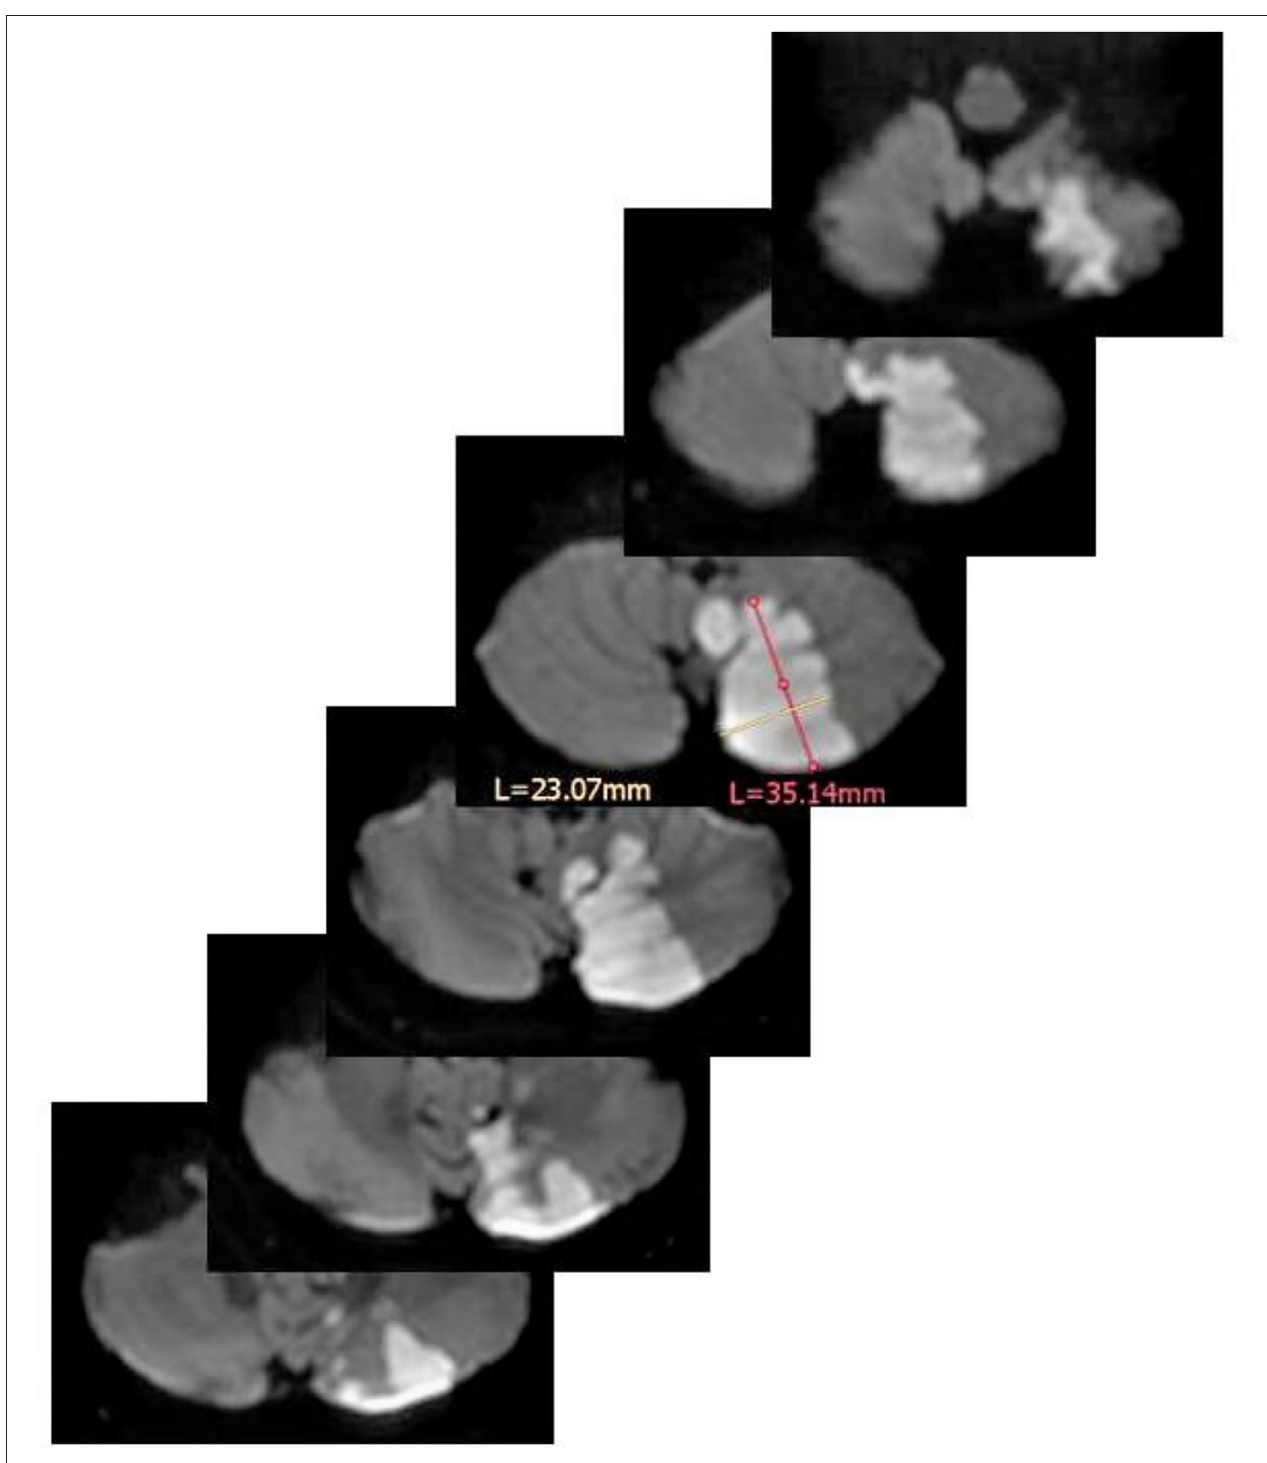
FIGURE 1 | Volume estimation of a left PICA infarction by means of the ABC/2 method. In the scan with the largest infarction A (in magenta) = 3.51cm, B (in yellow) = 2.30cm. Of note, A and B should stand perpendicular to each other. The thickness of each scan is 0.4cm. The resulting volume is: (3.51 × 2.30 × 0.4cm × 6)/2 = 9.68 cm 3 ( = 9.68ml). L = length of measurements in mm for A and B.